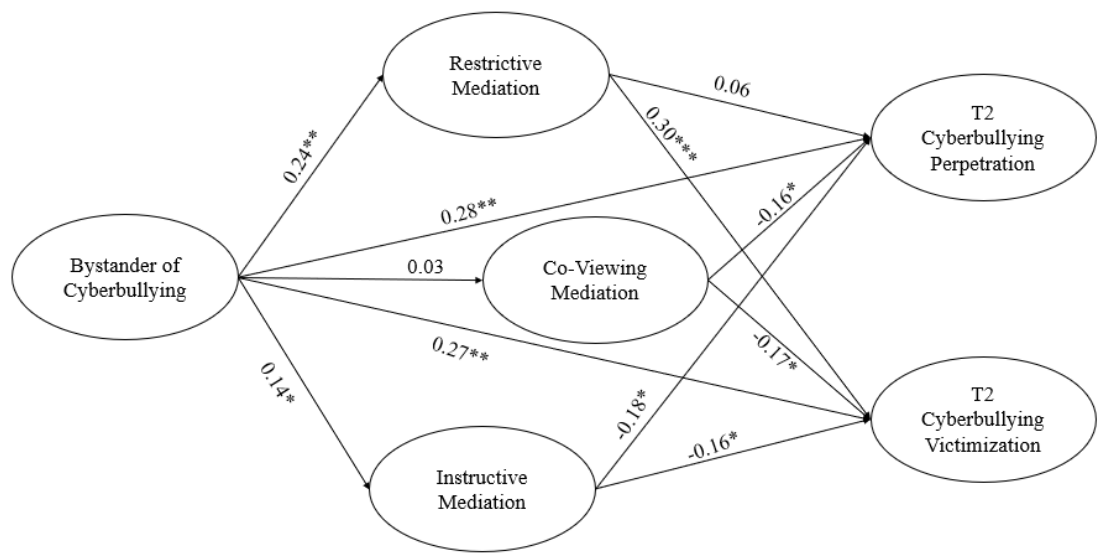
Figure 1. Graphical representation of the structural regression model. Note: T2 = Time 2. T1 cyberbullying perpetration and victimization were both controlled for by letting both variables predict T2 cyberbullying perpetration and victimization. T1 cyberbullying perpetration was related positively to T2 cyberbullying perpetration ( β = 0.20, p < 0.05). T1 cyber victimization was related positively to T2 cyberbullying victimization ( β = 0.19, p < 0.05). * p < 0.05. ** p < 0.01. *** p < 0.001.